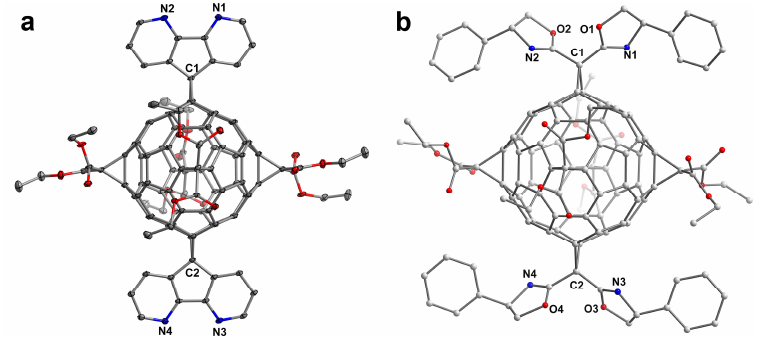
Figure 1. ( a ) Single-crystal structure of fullerene linker L1 with 15% thermal ellipsoids, and ( b ) the molecular structure of L2 . Hydrogen atoms were omitted for clarity.